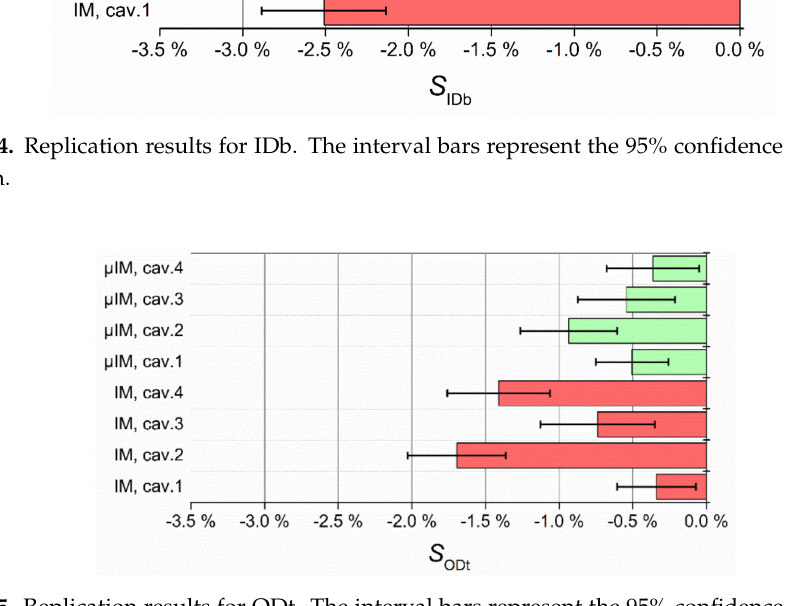
Figure 15. Replication results for ODt. The interval bars represent the 95% confidence intervals for the